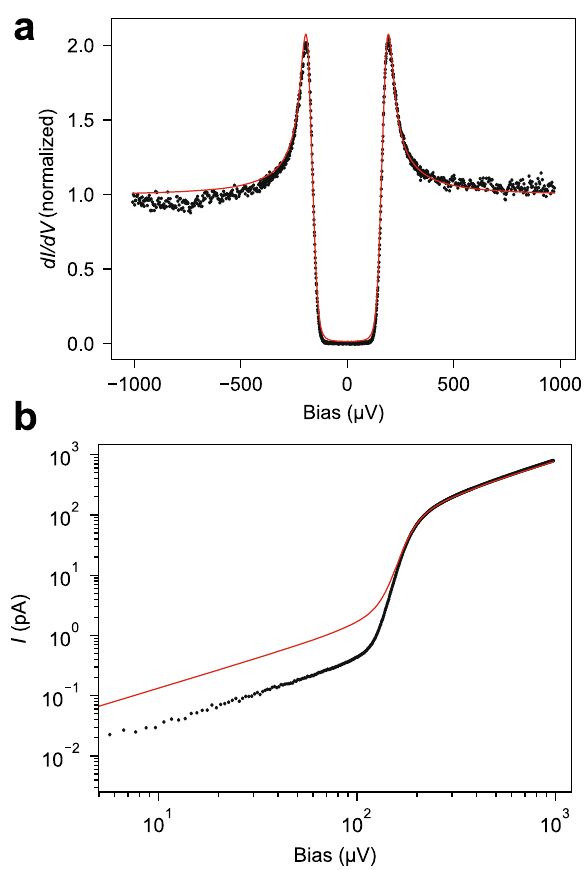
Fig. 6 Fitting the experimental differential conductance d I /d V spectrum of the superconducting gap. a Raw dI /d V spectrum of the superconducting Al(100) surface measured with a normal-metal tip at 44 mK and fi tted with Eq. (4), where the model density of states of a Bardeen-Cooper-Schrieffer (BCS) superconductor n BCS was substituted by the Dynes expression n D S S de fi ned in Eq. (6). For values of the fi t parameters, cf. text. b The I ( V ) curve (black dots) measured simultaneously with the d I /d V spectrum of panel (a) and fi tted (red line) using the same parameter set used for calculating the fi t in a , but complemented by the high-voltage or normal-state resistance of the junction, R = 1.2 M Ω .